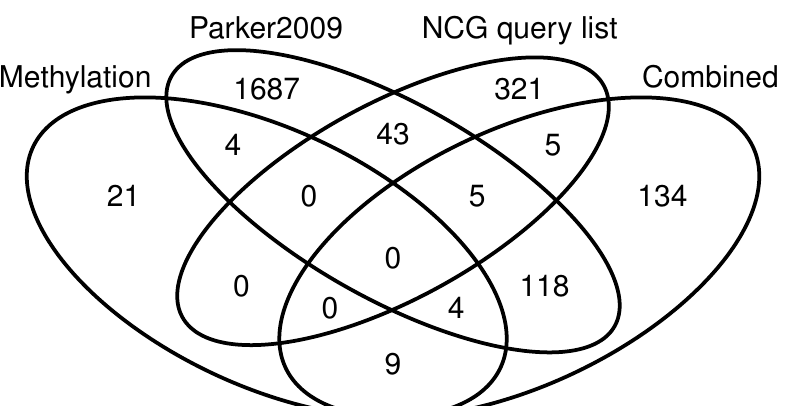
Figure 6: Venn diagram showing the overlap of the features selected by the combined model with a list of known breast cancer genes (downloaded 17-01-2014) from the Network of Cancer Genes [18] and with the list of intrinsic genes reported by Parker et al.